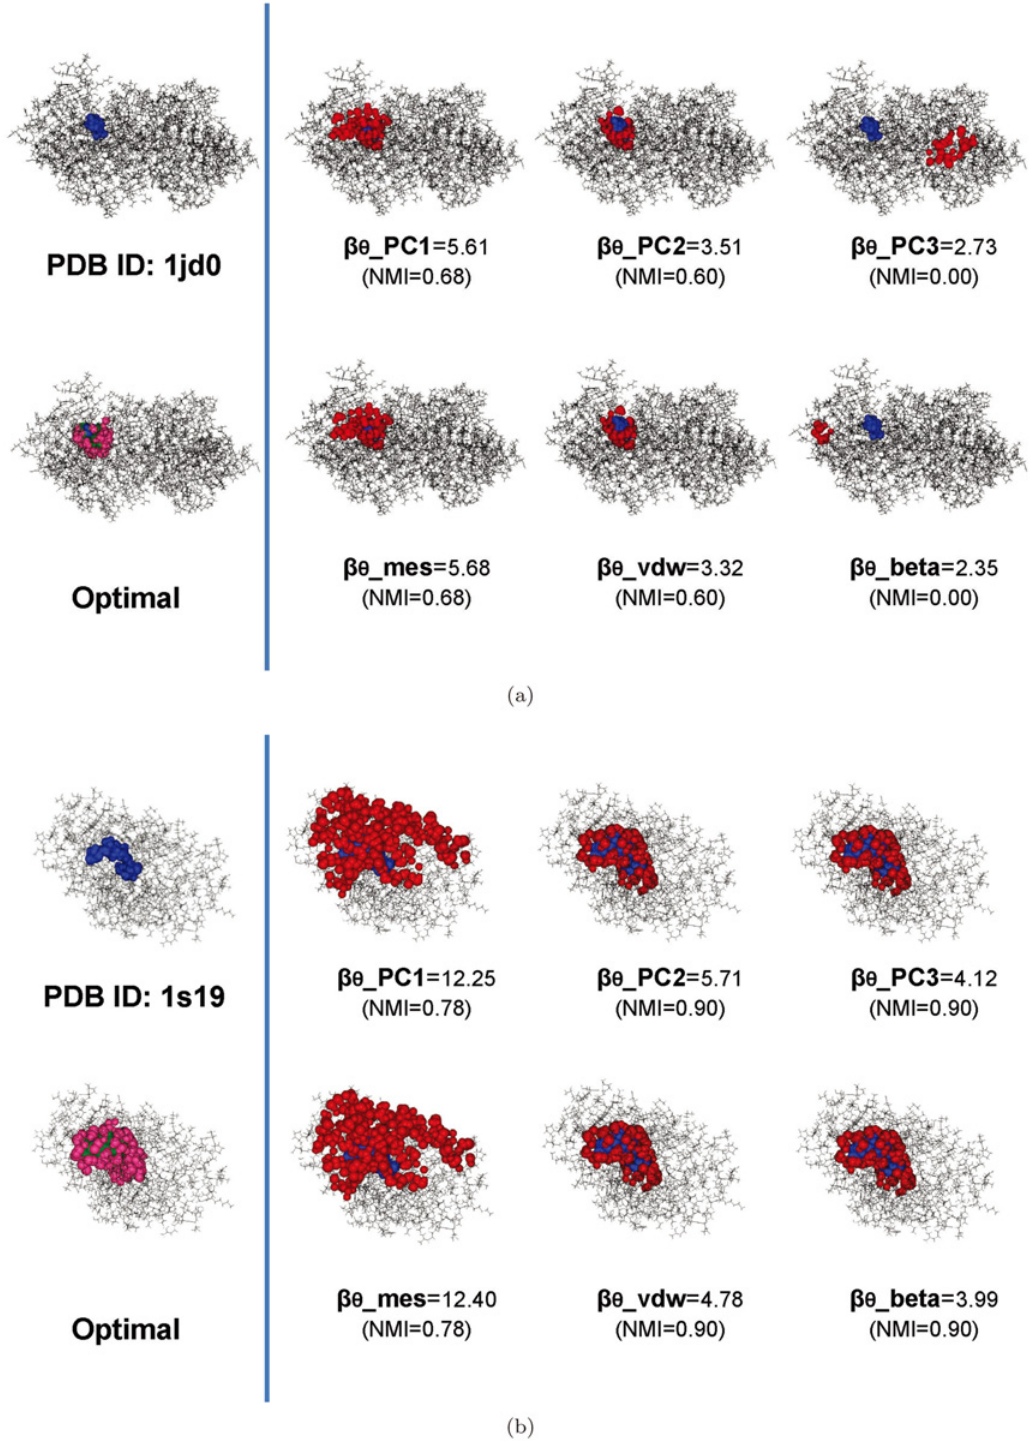
Fig 14. The optimal and recognized pockets of the PDB models. (a) PDB ID: 1jd0 (carbonic anhydrase XII — acetazolamide(18 atoms) complex) (b) PDB ID: 1s19 (vitamin D nuclear receptor-calcipotriol(70atoms) complex). The atoms are the colored receptor in black, the ligand in blue, the optimal pocket in pink, and the recognized pocket in